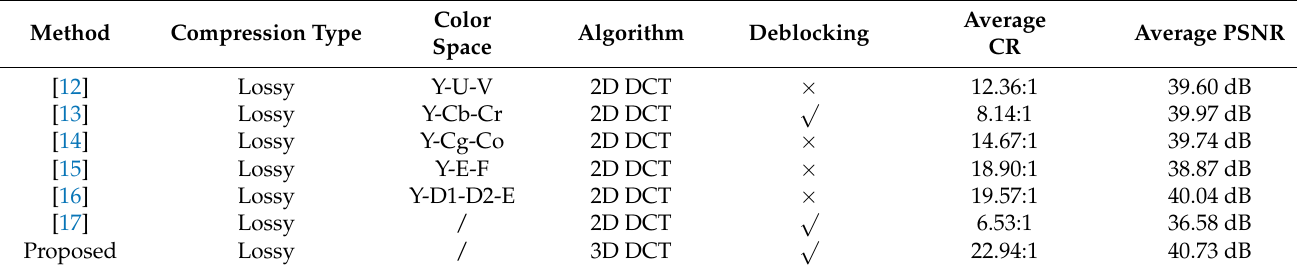
Figure 11. Objective evaluation base on 7 sub-datasets corresponding to 7 patients. ( a ) shows the average CR of each methods in the seven patients, and ( b ) shows the average PSNR of each meth- ods in the seven patients, where the dotted line indicates PSNR = 40 dB. Table 2. Comparison of state-of-the-art methods. Table 2. Comparison of state-of-the-art